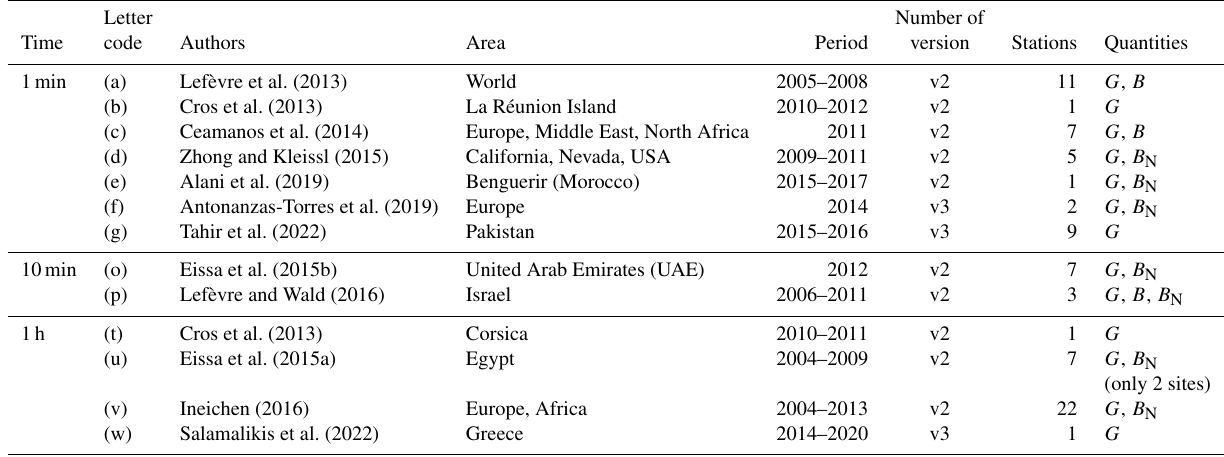
Table 13. List of selected published works comparing McClear outputs and in situ measurements for summarization 1min, 10min and 1h (column time) and some of their characteristics. The letter code is used in the following tables.